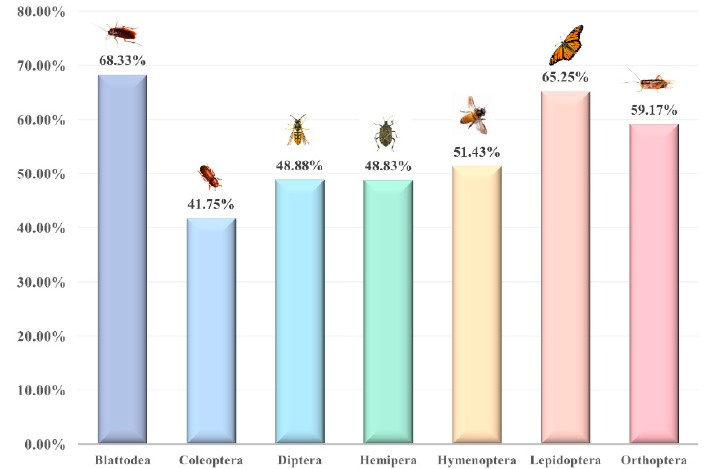
Figure 2. The protein content of edible insects of several common orders [10] . Table 1. Proximate composition of insect matter.